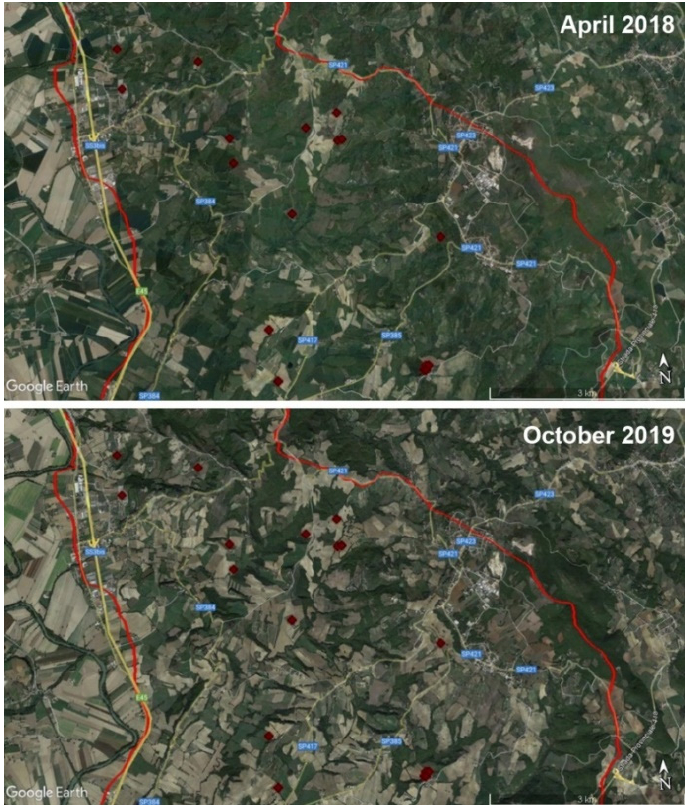
Figure 5. Two aerial images of the central part of the study area (red dots represent shallow landslides). In October, the area is devoid of any vegetation (many brown areas); in April, several zones are fully vegetated (green). Background images from Google Earth.